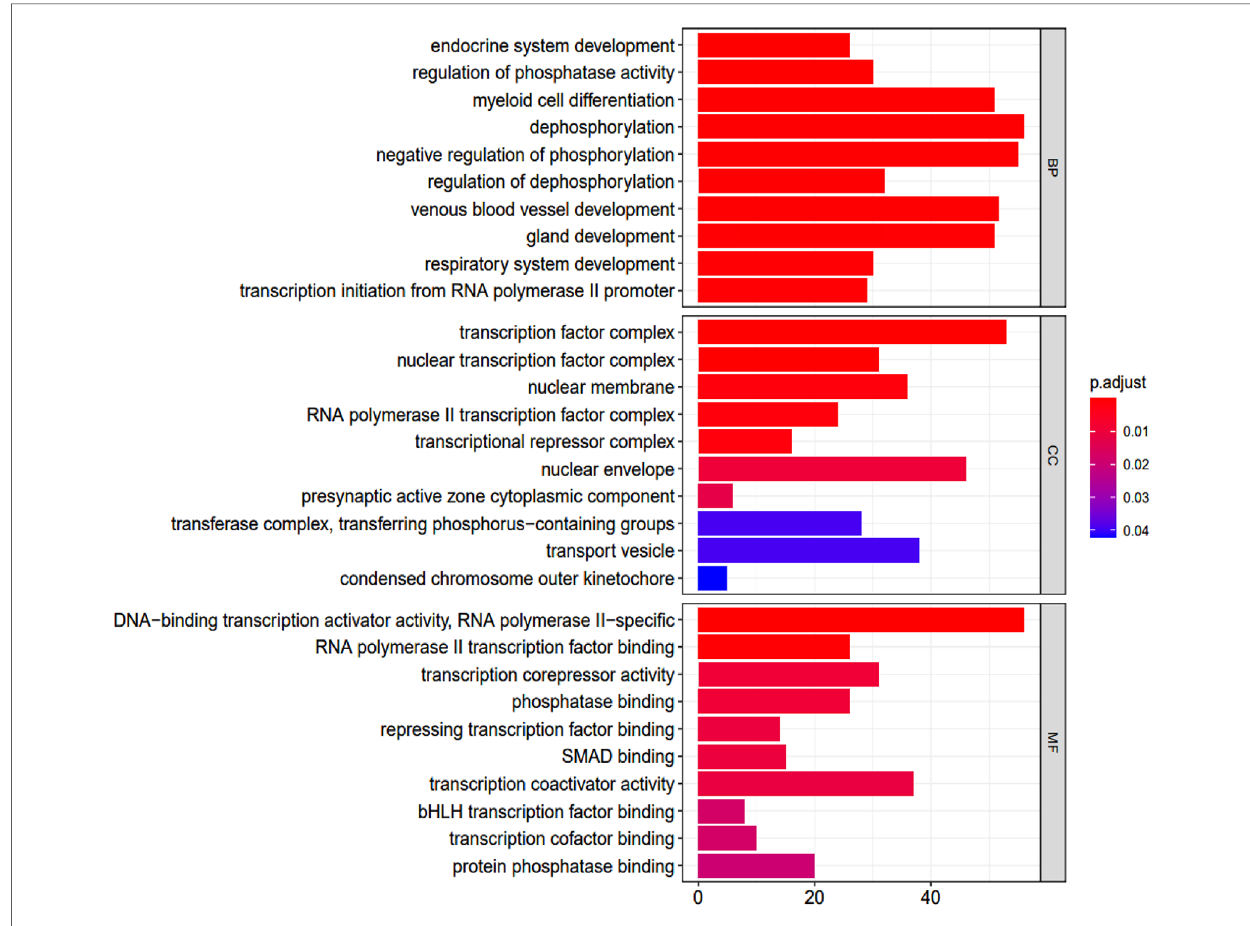
FIGURE 4 Go enrichment analysis. BP, biological process; CC, cellular component; MF, molecular function.